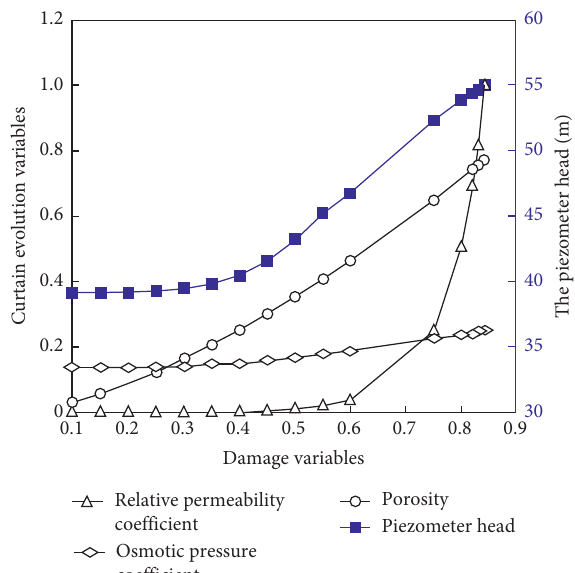
Figure 15: Damage evolution of the permeability characteristics of the curtain rock